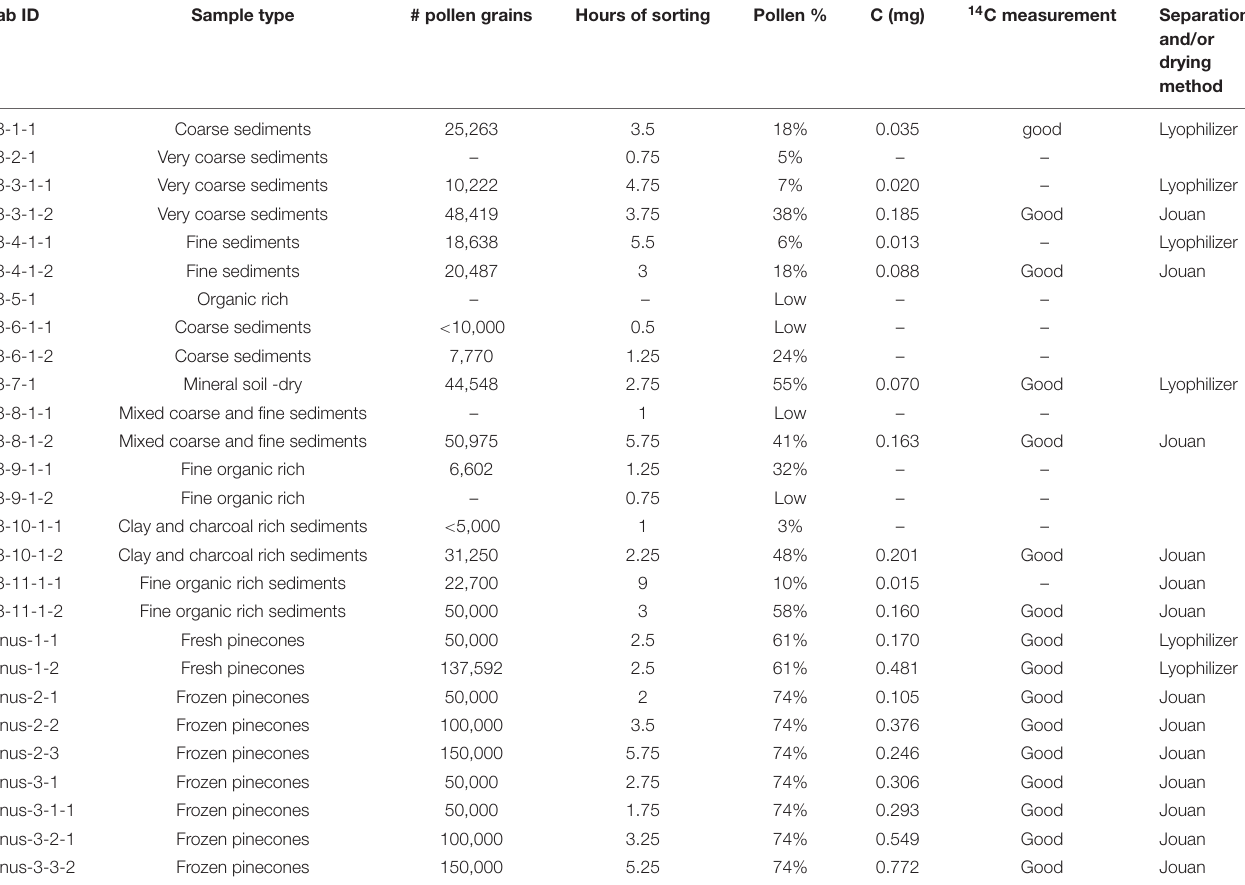
TABLE 2 | Modern samples from surface transect T8 ( Figure 1 ) and fresh pinecones. Lab